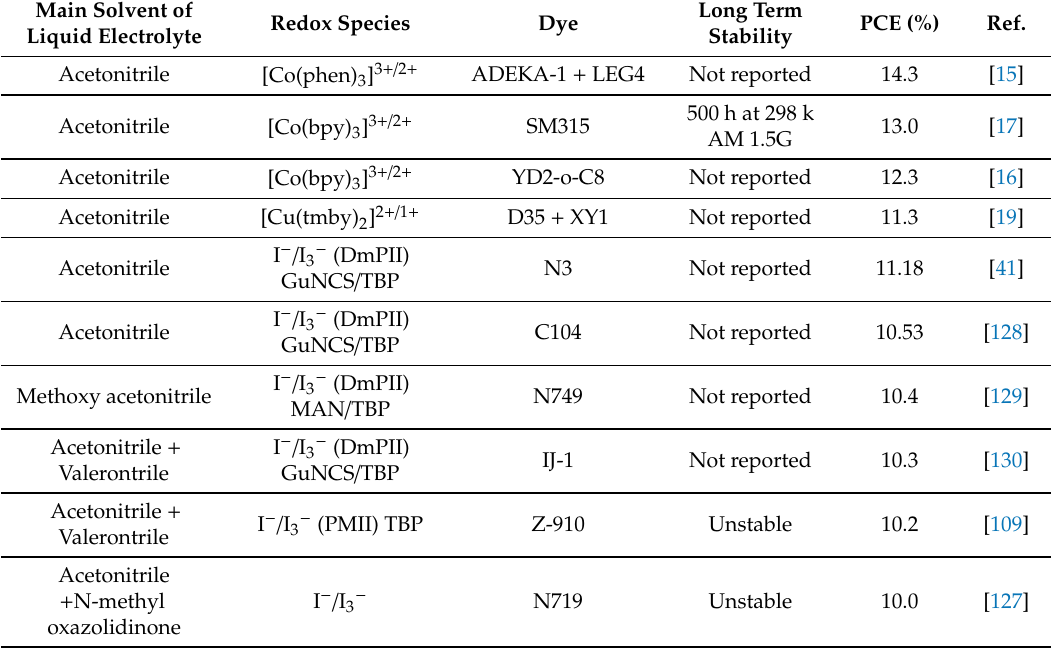
Table 2. Highest power conversion e ffi ciencies (PCEs) reported for liquid electrolytes utilizing organic solvents in